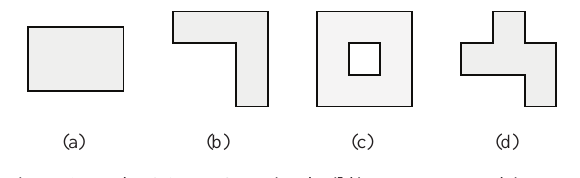
Figure 2: In the GANDIS project buildings are grouped into sets with similar shape. The following basic shapes are used: rectan-